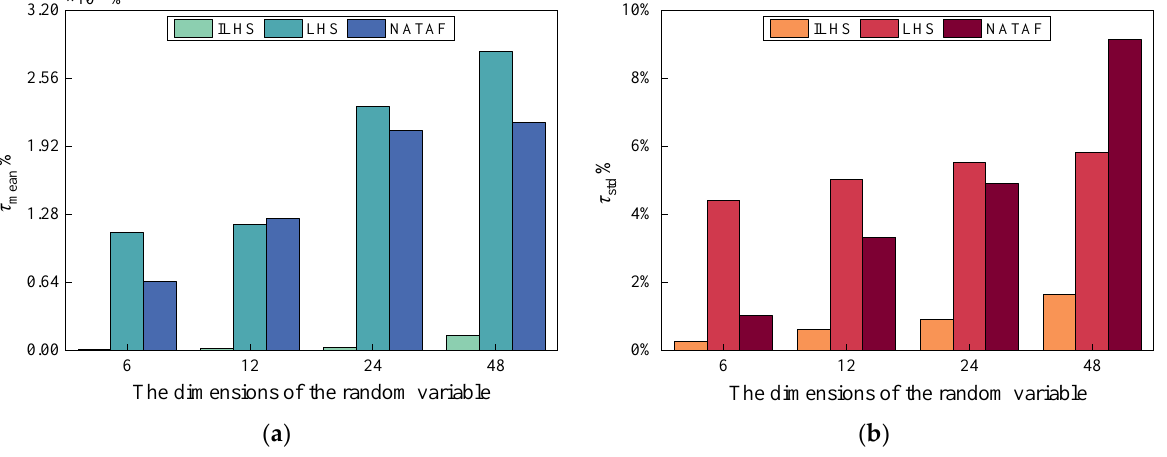
Figure 13. Comparison of ( a ) the mean error and ( b ) the standard deviation error of the active power at the converter stations under different random variable dimensions.